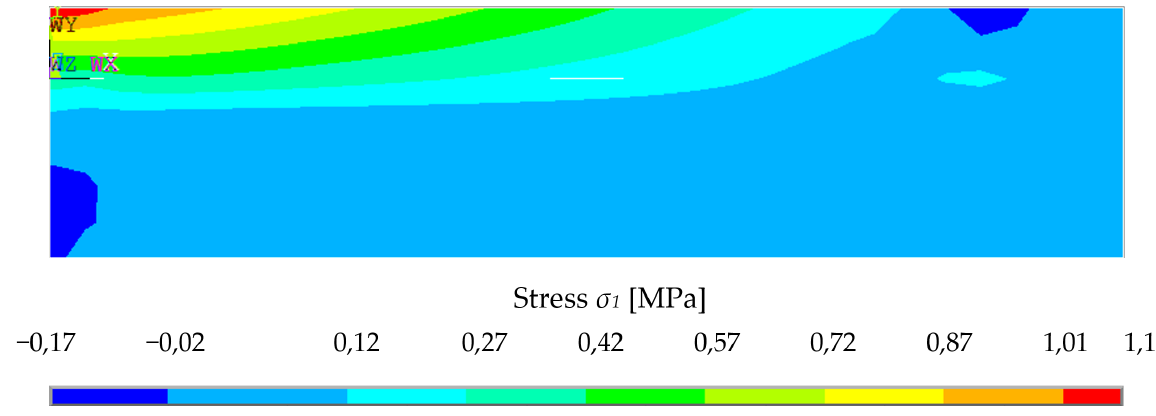
Figure 30. Stresses iso-areas over longitudinal-section.